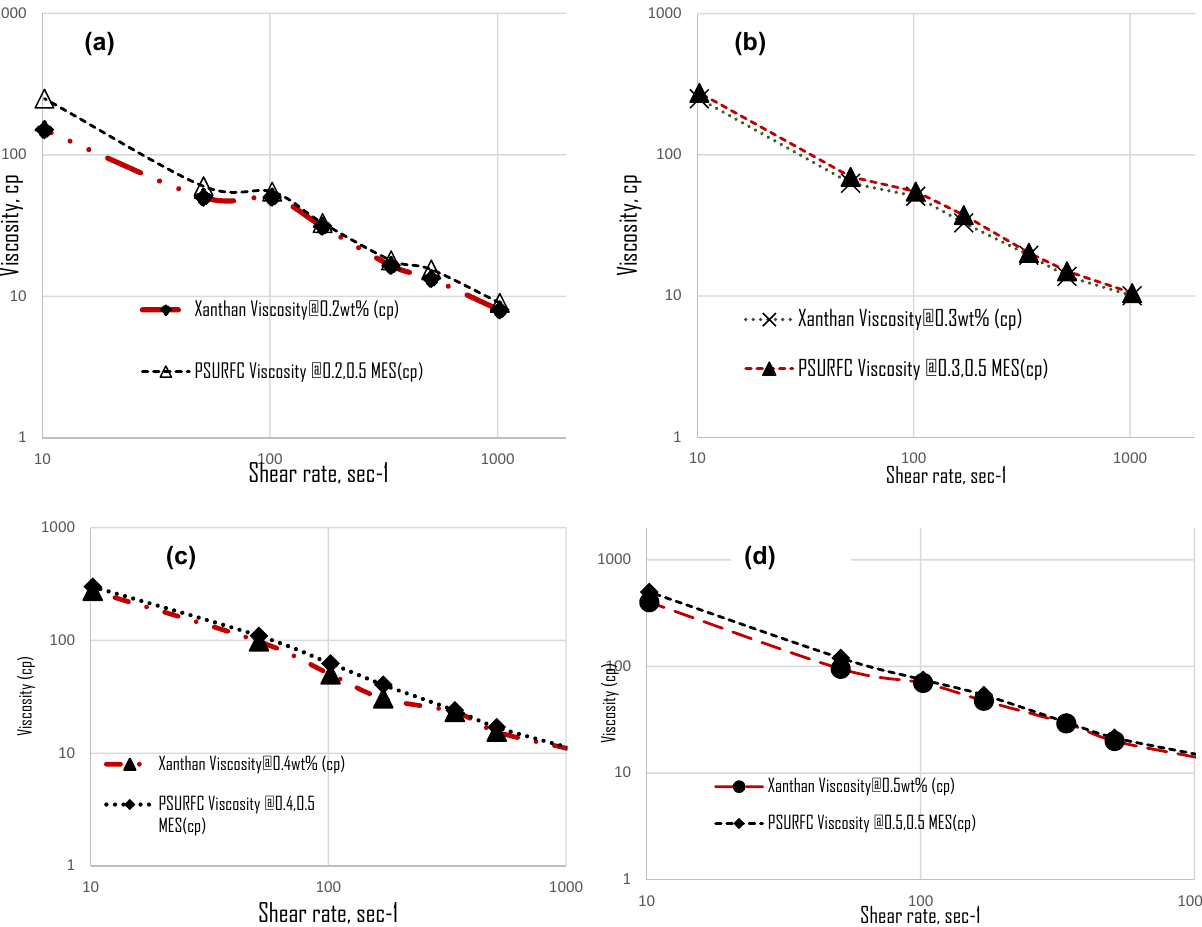
Fig. 6 Curves of polymer shear resistance of polymer and PSURFC solution. A slight change in the viscosity as in ( a ), ( b ), ( c ) and ( d ). Above displays an enhancement in polymer concentration on intro-